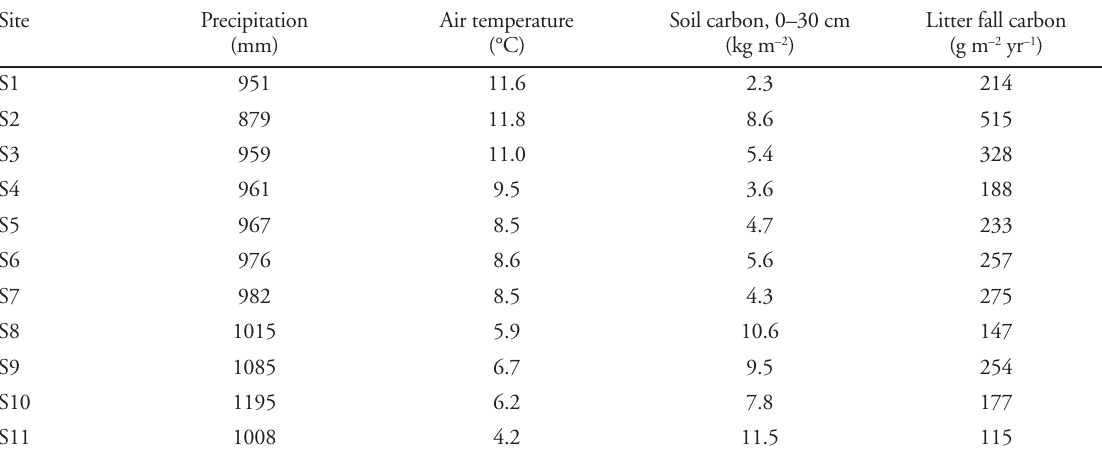
Table 1. Summary of precipitation, air temperature, soil carbon and litter fall carbon of 11 sampling sites. Original data from Rodeghi- ero and Cescatti (2005).